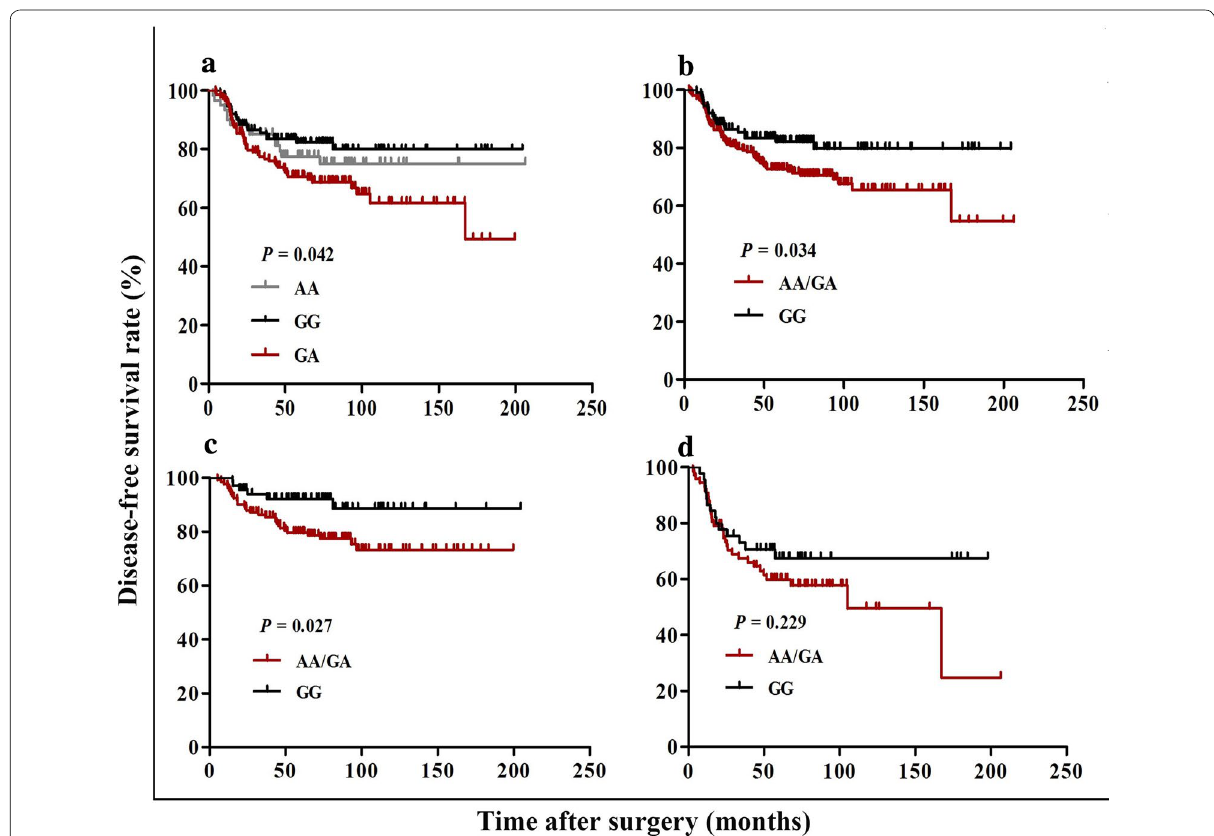
Fig. 1 Association between the autophagy-related gene 5 ( ATG5 ) single-nucleotide polymorphism (SNP) rs473543 genotypes and disease-free survival (DFS) in early-stage triple-negative breast cancer (TNBC) patients. DFS of the patients grouped according to ATG5 rs473543 genotypes. a GG vs. GA vs. AA in the whole cohort; b GG vs. AA/GA in the whole cohort; c GG vs. AA/GA among patients without axillary lymph node involvement; d GG vs. AA/GA among patients with axillary lymph node